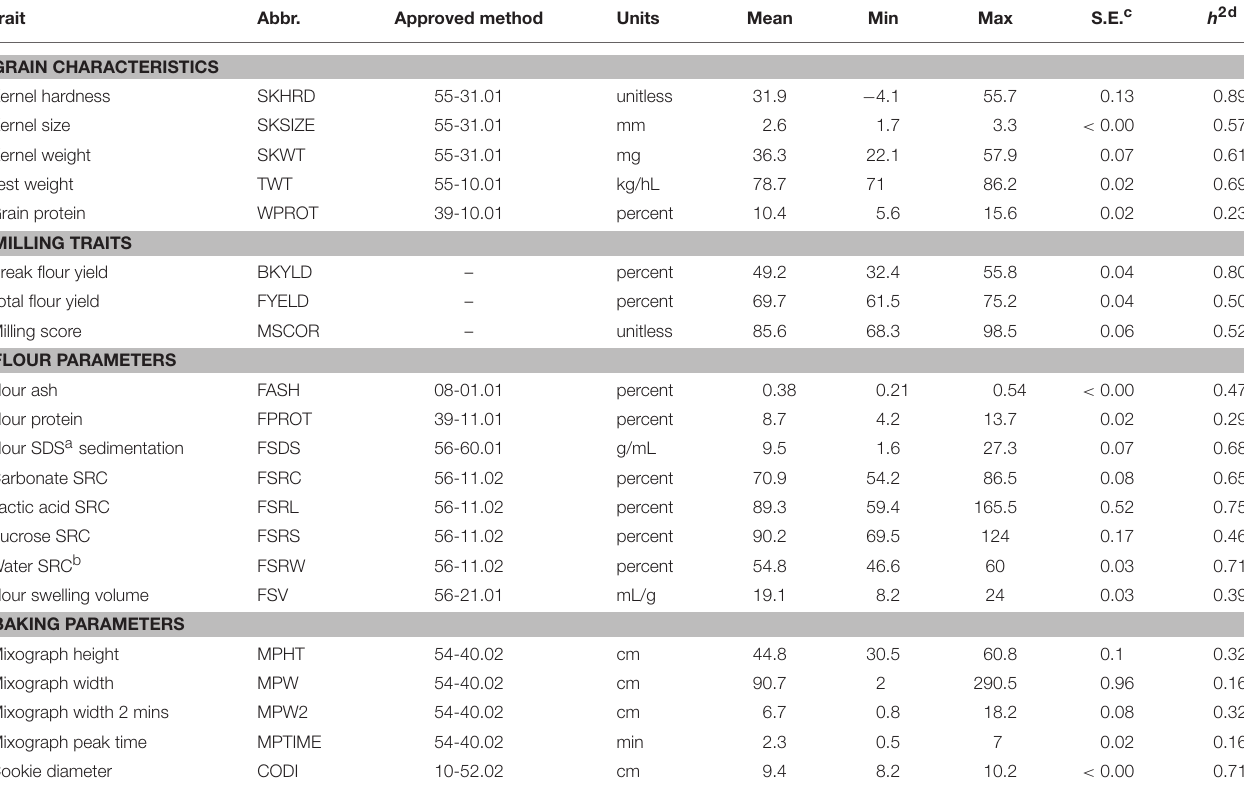
TABLE 1 | Approved methods, units, means, and ranges of end-used quality traits in a Pacific Northwest soft white winter wheat diversity panel.